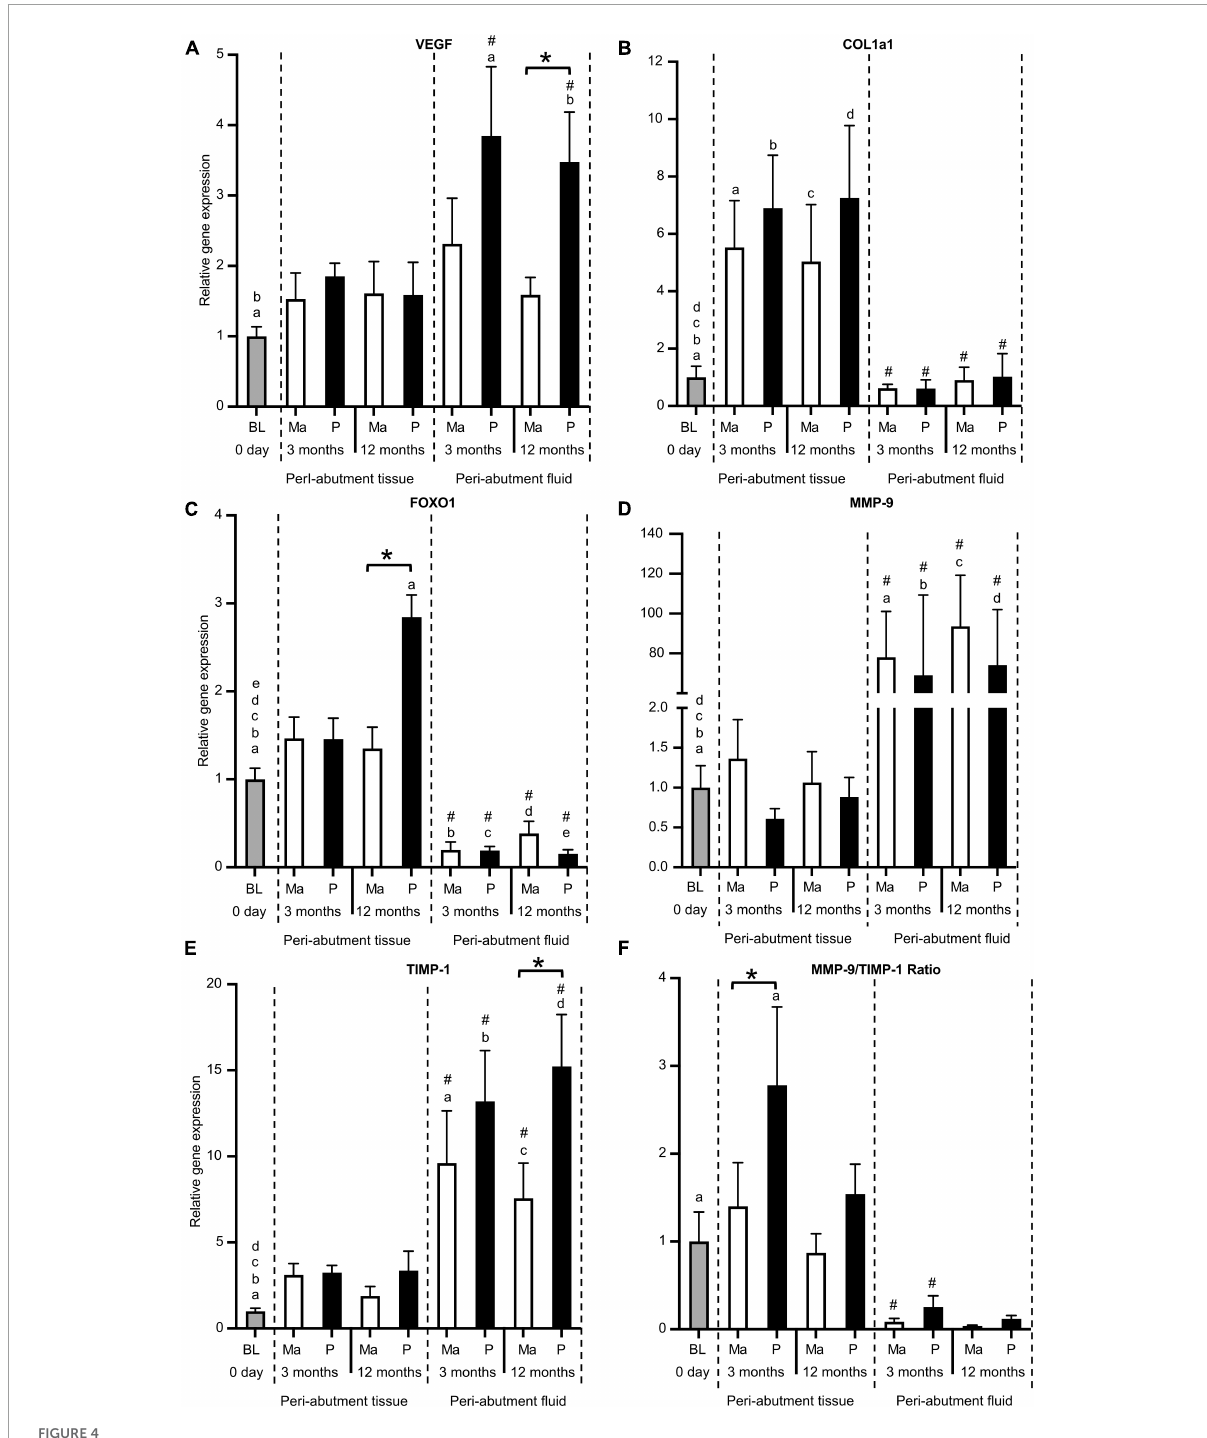
FIGURE4 Gene expression of vascularisation, tissue regeneration, tissue degradation, and remodelling factors. (A) Vascularisation factor vascular endothelial growth factor (VEGF). (B) Extracellular matrix component collagen 1a1 (Coll1a1). (C) Transcription factor forkhead box protein O1 (FOXO1). (D) Tissue degradation enzyme matrix metallopeptidase 9 (MMP9). (E) Tissue inhibitor of metalloproteinase (TIMP1). (F) Gene expression ratio of MMP9/TIMP1. The column graphs show the relative gene expression at baseline (BL) and in the peri-abutment tissue and peri-abutment fluid at machined (M) and electropolished (P) abutments after 3 and 12 months of implantation. Statistically significant differences ( p < 0.05) between BL and either compartment (“Peri-abutment tissue” or “Peri-abutment fluid”) and between the two compartments are indicated by similar small letters and hash signs, respectively. The differences between machined and electropolished abutments for each compartment are indicated by bars and